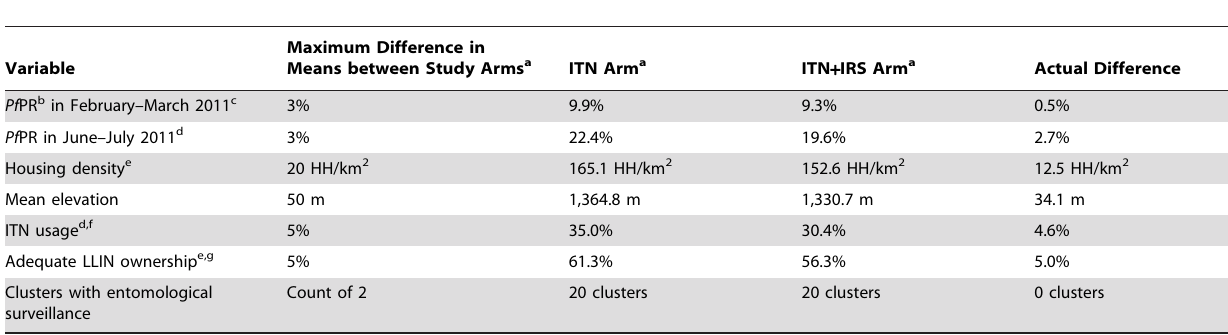
Table 1. Restriction variables for randomisation and realisation of balance between the study arms.